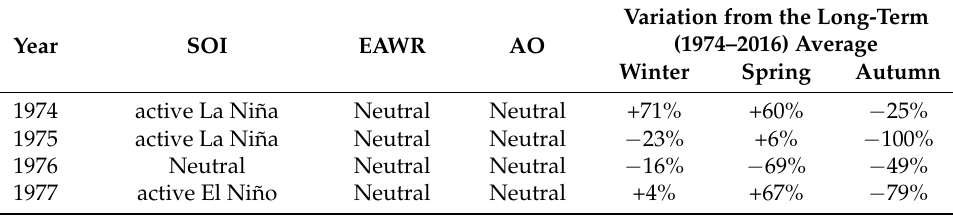
Table 4. The classification of climate indices and total changes in seasonal precipitation between 1974 and